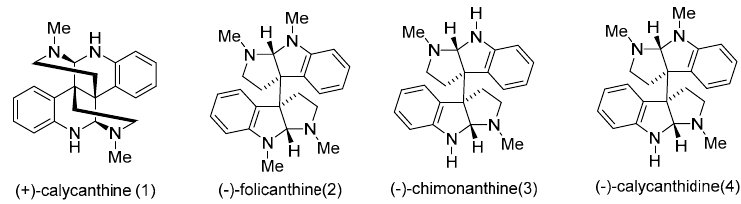
Figure 1. Structures of calycanthaceous alkaloids.